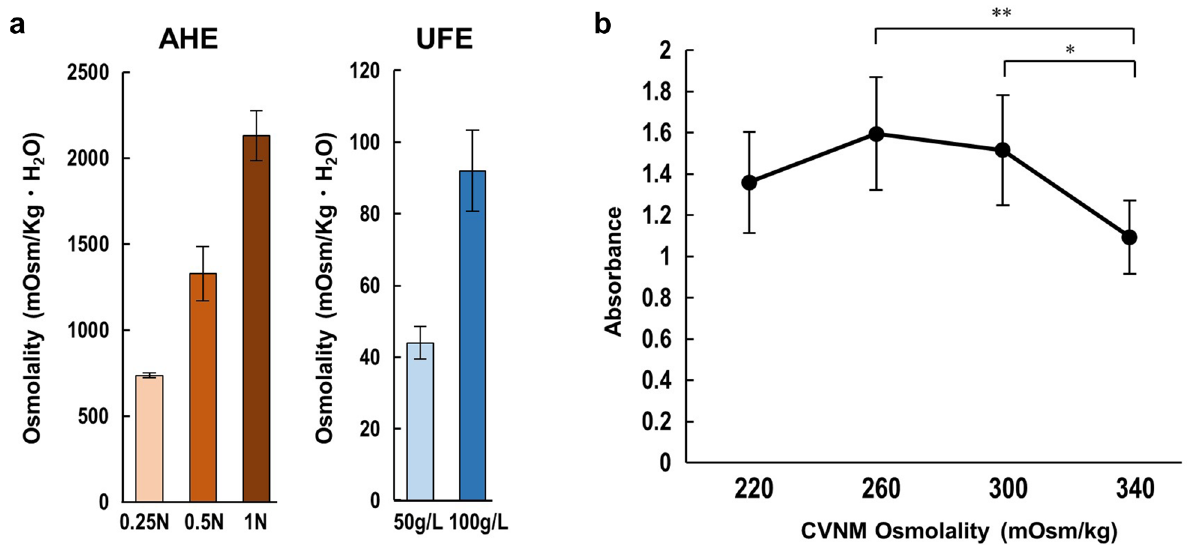
Figure 5. Effects of changes in osmolality on RL34 cell viability. ( a ) Osmolality of the different concentrations of CVE. Data are presented as the mean ± standard deviation (n = 6–10). ( b ) Cell viability of RL34 cell cultured under ISS containing 15% CVE (0.5 N AHE and UFE mixed at 1:1; 15% CVNM) at osmolalities of 220, 260, 300, and 340 mOsm/kg. Data are presented as the mean ± standard deviation (n = 7). ** P < 0.01, * P < 0.05. AHE, acid hydrolysis extract; CVE, Chlorella vulgaris extract; CVNM, C. vulgaris -derived nutrient media; ISS, inorganic salt solution; UFE, ultrasonic fractionated CVE-based media for the data sets of the conditions as shown in Supplementary Fig. S1. Figure 7 provides an excerpt of the results of representative conditions that were subsequently followed. Further, the gene expression levels of the satellite cell marker PAX7 and the myogenic determinant genes, MYOD and MYF5, were analyzed by real-time quantitative PCR (RT-qPCR) before and after 48 h of culture in DMEM with 10% FBS and CVNM-CM with 10% CVE. The expression of PAX7 mRNA was not significantly